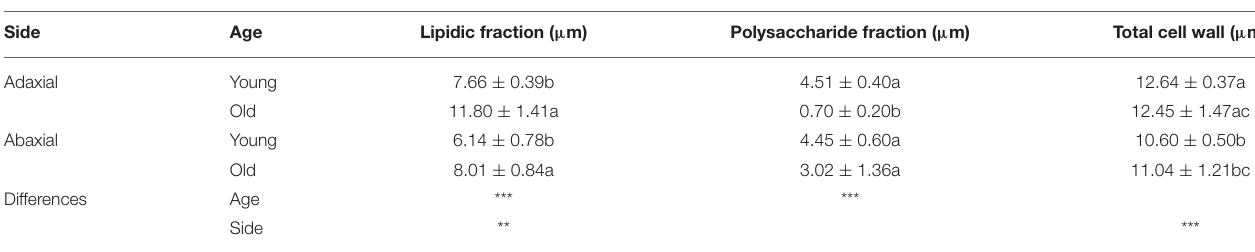
TABLE 1 | Thickness of different external epidermal cell wall